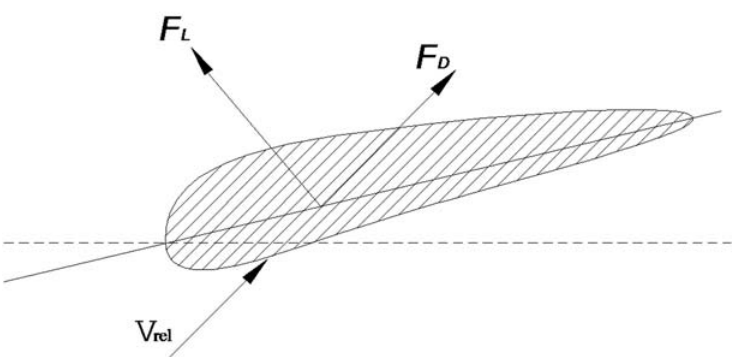
Figure 5. The forces of the airfoil.